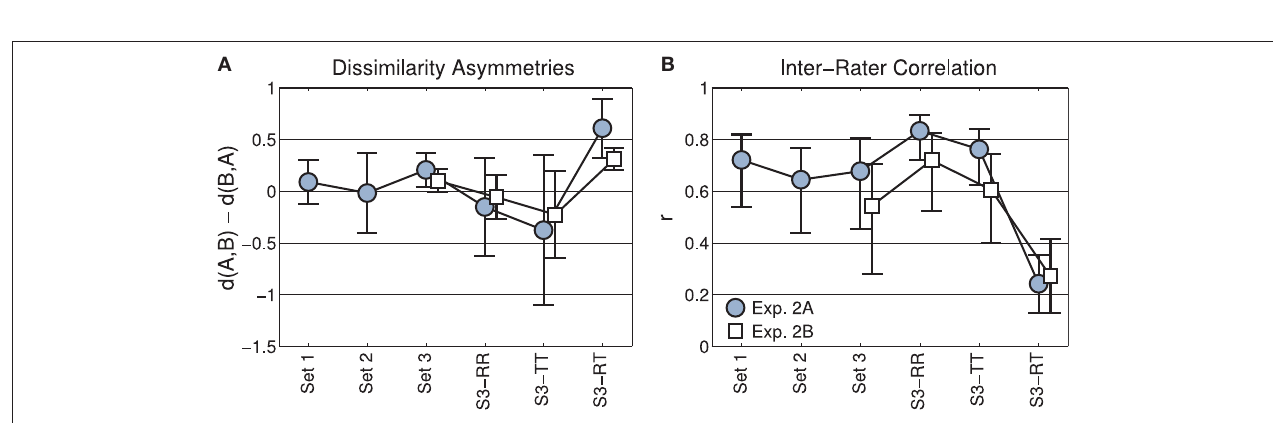
FIGURE 4 | Experiments 2A and 2B. (A) Mean rating asymmetries across the three sets, and the subsets of Set 3 with the pairs recording-recording (RR), transformation-transformation (TT), recording-transformation (RT). Errorbars indicate 95% confidence intervals. (B) Inter-rater agreement as measured by mean Pearson correlation coefficients. Errorbars indicate 95% confidence intervals obtained by